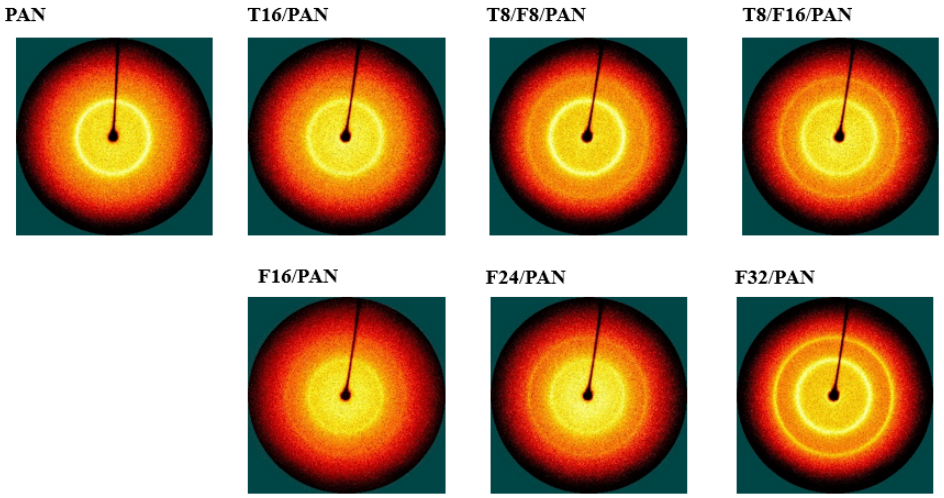
Figure 7. 2D WAXD patterns of the PAN-based conductive yarn by different contents of carbon nanomaterials. Table 7. Degree of the crystal orientation in the PAN-based composite yarn with different contents of carbon nanomaterials.